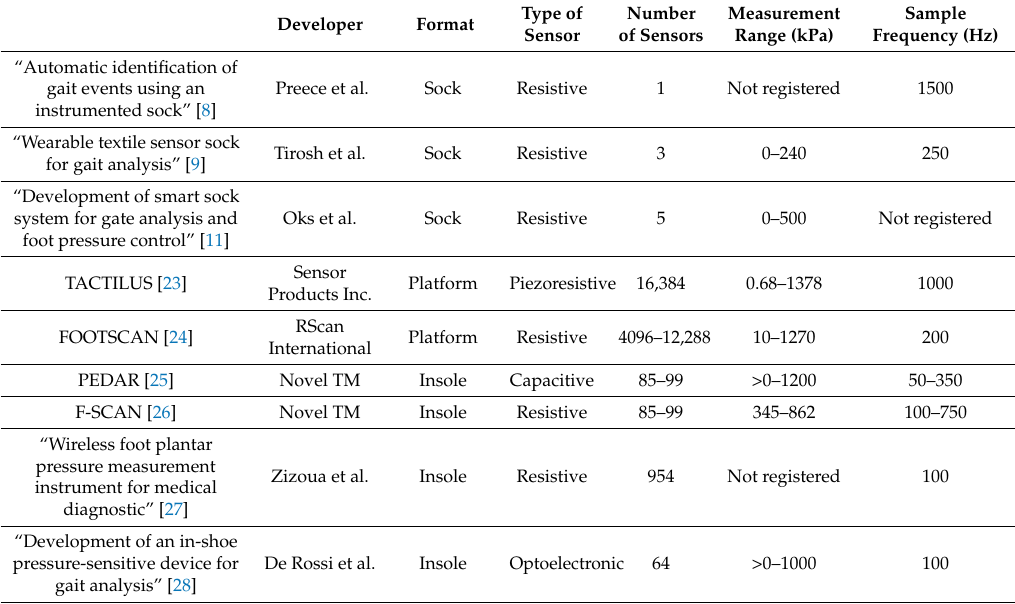
Table 1. Plantar pressure measurement